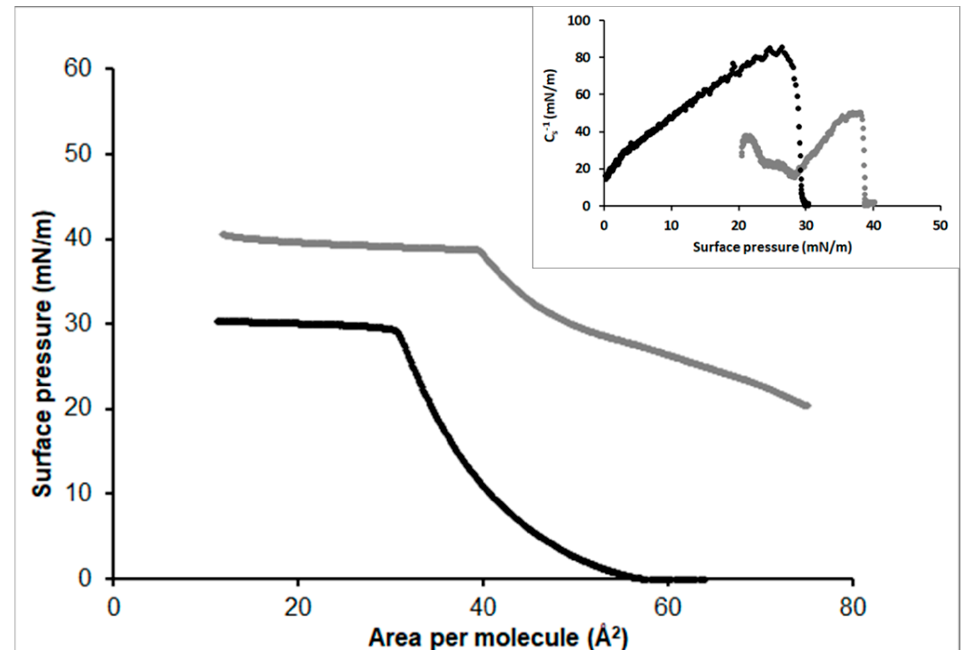
Figure 3. Surface pressure-area isotherms for OA in the absence (black) and in the presence (grey) of lysozyme. Inset: Elastic modulus curves from the isotherms of Figure 3 for OA in the absence (black) and in the presence (grey) of lysozyme.